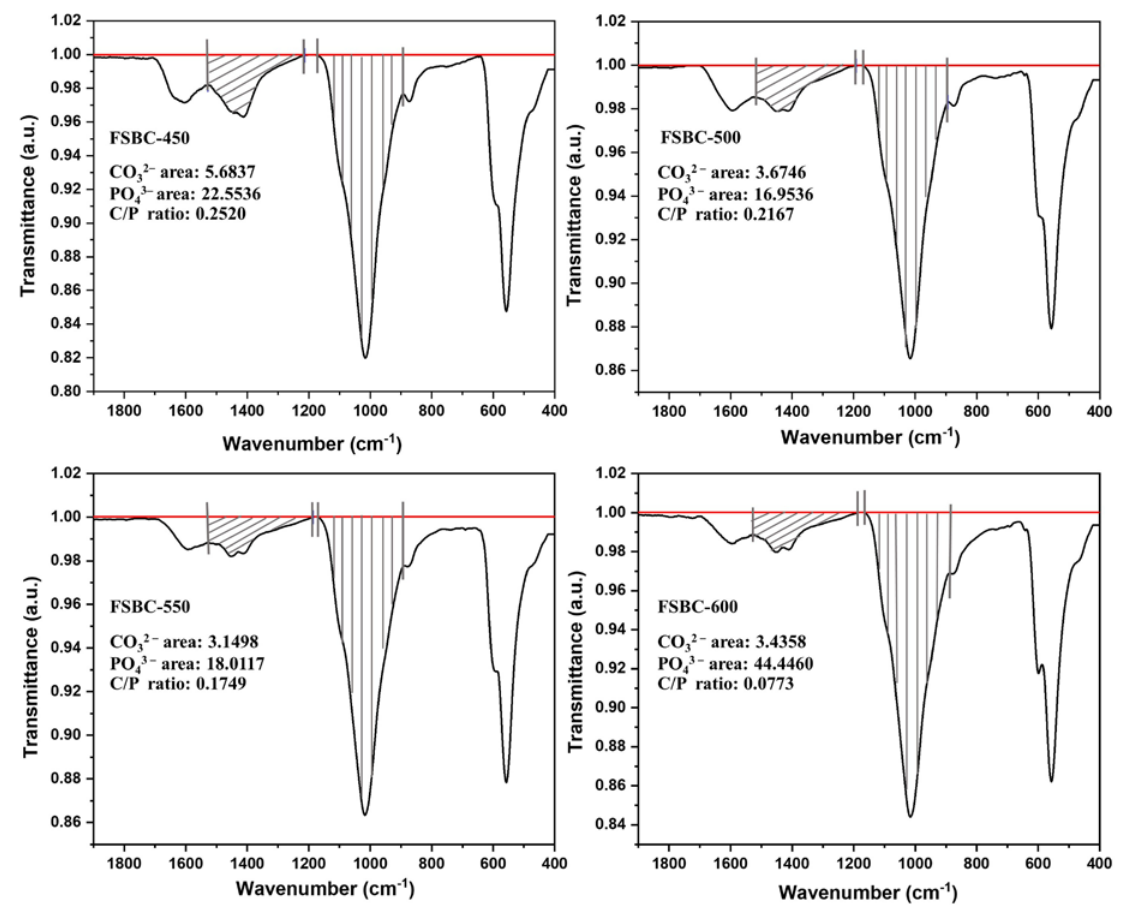
Figure 7. FTIR spectra of the obtained FSBC products showing the calculation of CO 32 − /PO 43 −